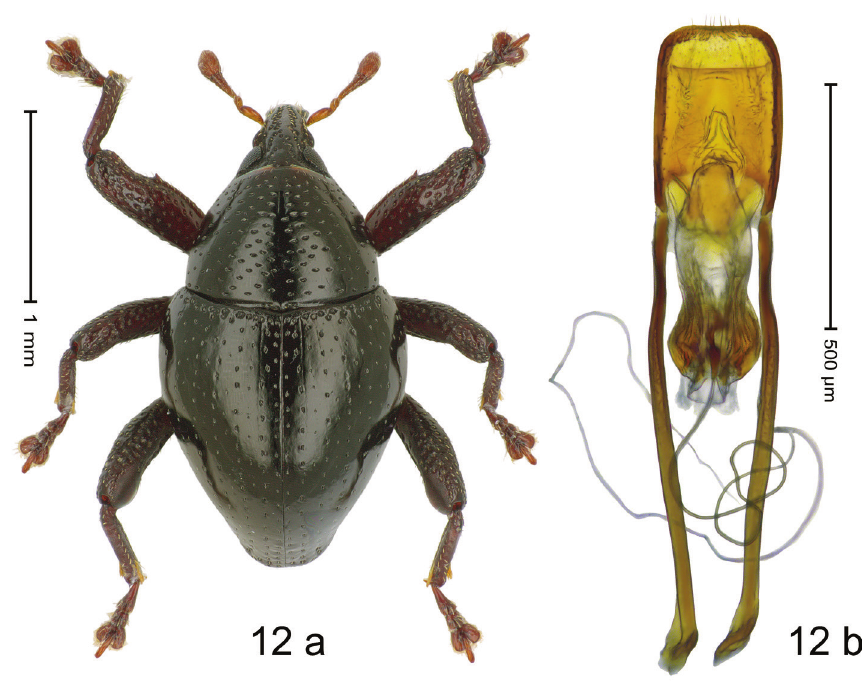
Figure 12. Trigonopterus matakensis sp. nov., holotype a habitus b penis.